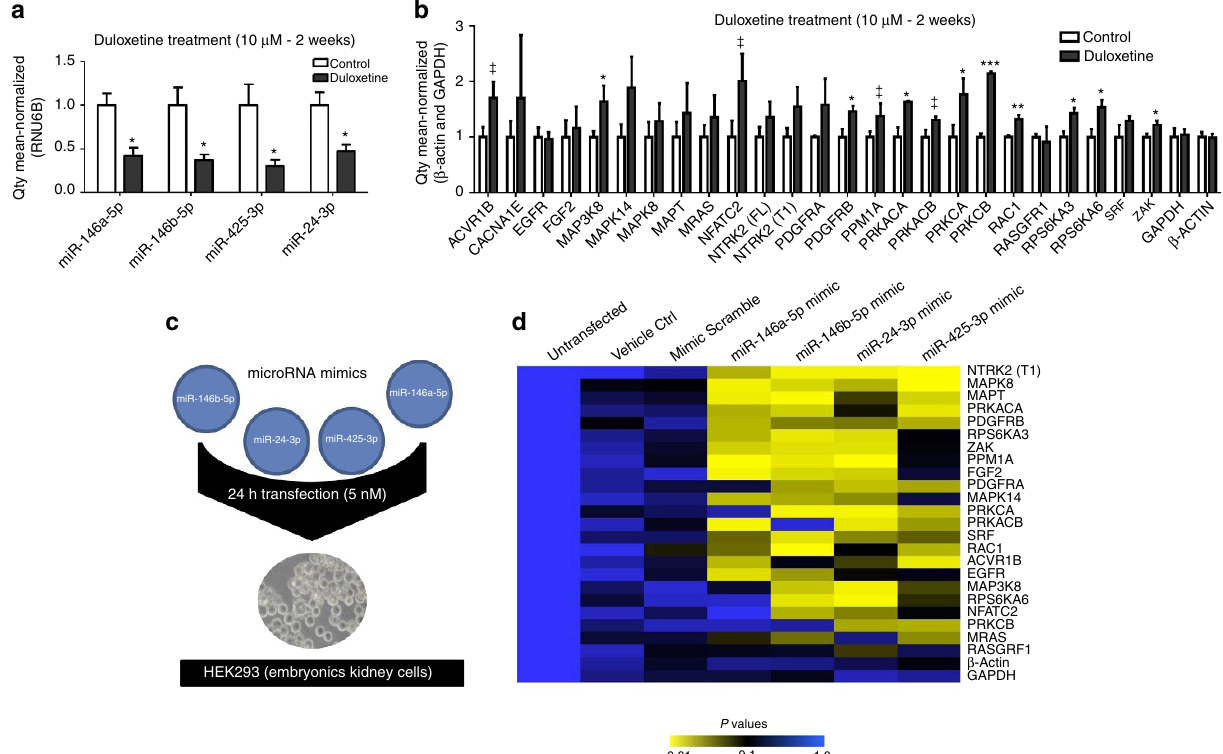
Figure 5 | MicroRNA dysregulation of MAPK and Wnt signalling pathways. ( a ) Expression of miR-146a-5p, miR-146b-5p, miR-24-3p and miR-425-3p in human NPCs treated with duloxetine or a no-drug control for 2 weeks (chronic treatment). * P o 0.05. ( b ) Expression of MAPK/Wnt target genes in human NPCs treated with duloxetine or a no-drug control for 2 weeks (chronic treatment). * P o 0.05; ** P o 0.01; *** P o 0.001; z P o 0.1. ( c ) Overexpression of miRNAs using miRNA mimics on human embryonic kidney cells (HEK293). ( d ) Heatmap showing P values of MAPK/Wnt target genes after overexpression of miRNAs in HEK293